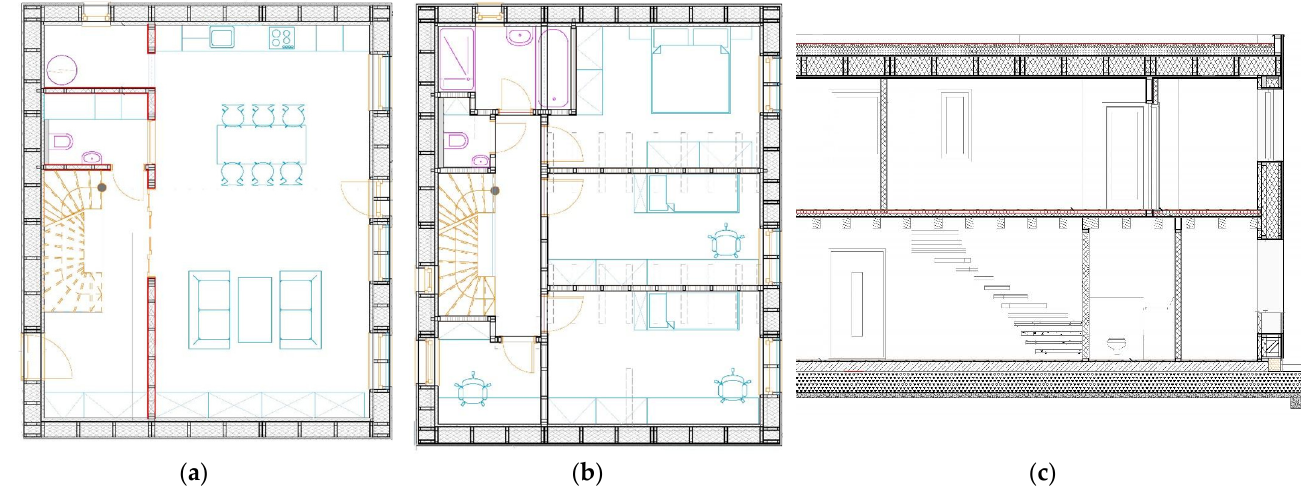
Figure 1. Scheme of the reference building: ( a ) ground floor plan; ( b ) first floor plan; ( c ) cross-section of the building.